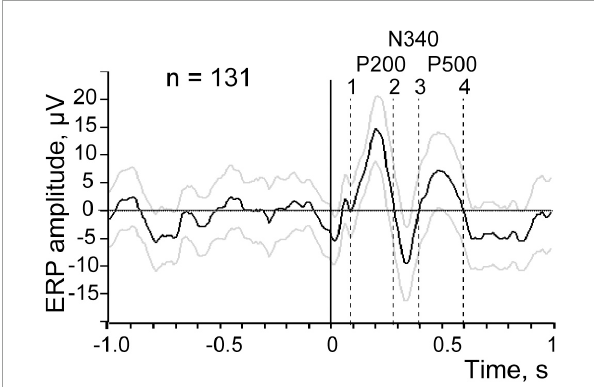
FIGURE2 Evoked response to visceral stimulation averaged across the entire recording session, the averaging is triggered by all stimulation ( n = 131). Black line demonstrates the mean amplitude, gray lines signify ± 2 SEM. Positive ERP components are marked by P and the negative one by N. Vertical dashed lines show time intervals used for further analysis.